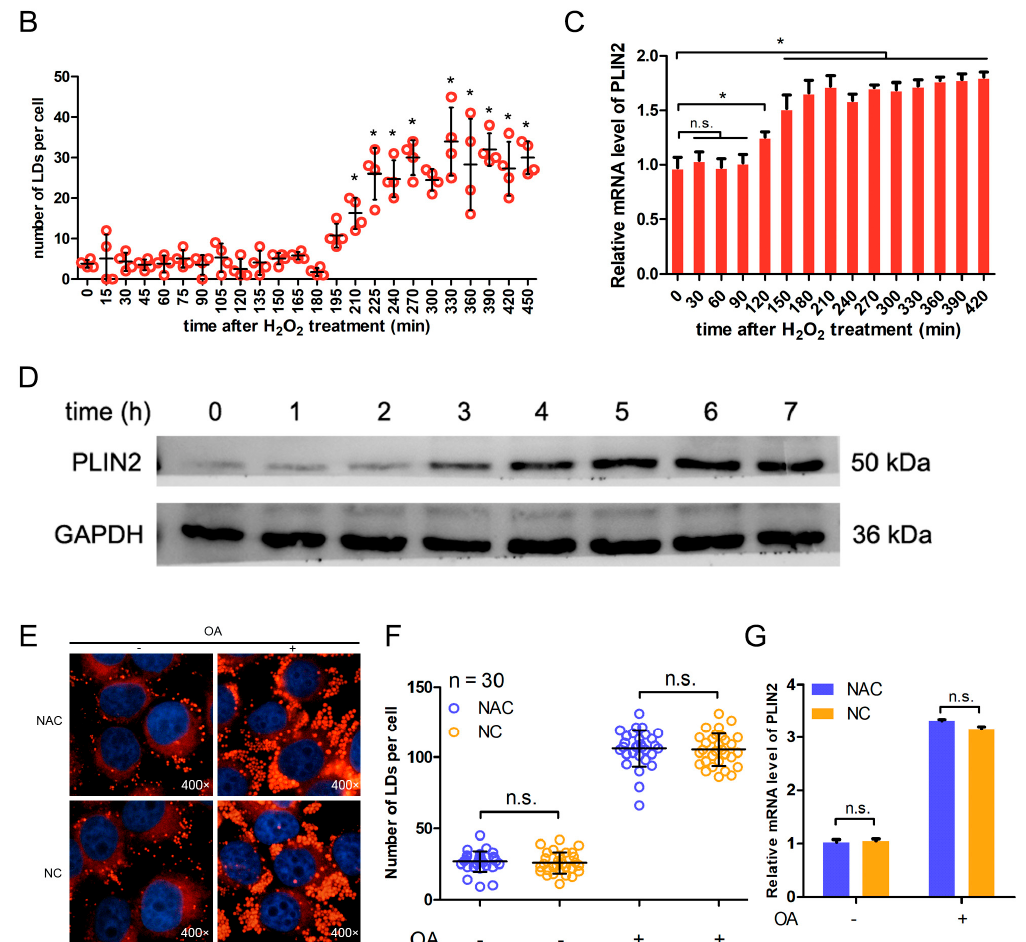
Figure 4. Hydrogen peroxide treatment promotes the formation of lipid droplets through up-regulating PLIN2. ( A ) The changes of cellular lipid droplets along with time after the treatment of 200 µ M hydrogen peroxide. Scale bar, 20 µ m. ( B ) Statistical analysis of the number of lipid droplets. *, p < 0.05. ( C ) The changes of PLIN2 expression along with time after the treatment of 200 µ M hydrogen peroxide. *, p < 0.05. ( D ) Detection of PLIN2 protein expression level after the hydrogen peroxide treatment. ( E ) Detection of lipid droplets in cells treated with 1 mM NAC (N-Acetylcysteine) and 1 mM OA. ( F ) Statistical analysis of the number of lipid droplets. n.s., not significant. ( G ) Detection of expression of PLIN2 in cells treated with 1 mM NAC and 1 mM OA. n.s., not